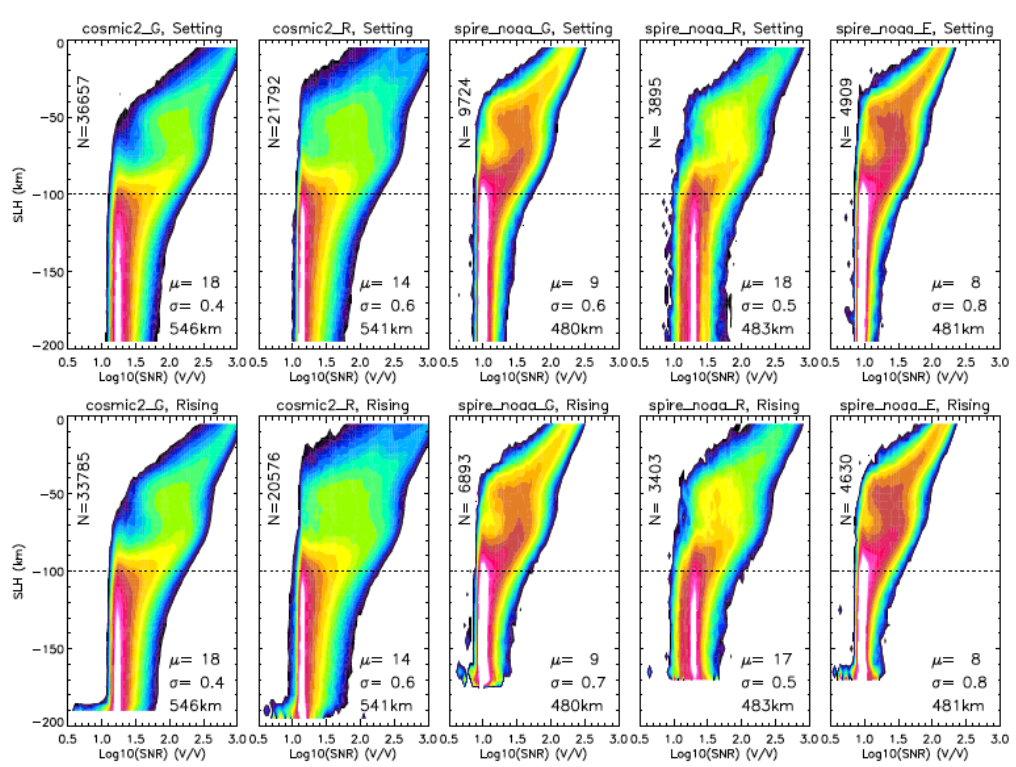
Figure A4. As in Figure A2 but for COSMIC-2 and Spire. The 2022 data are used in the analysis.